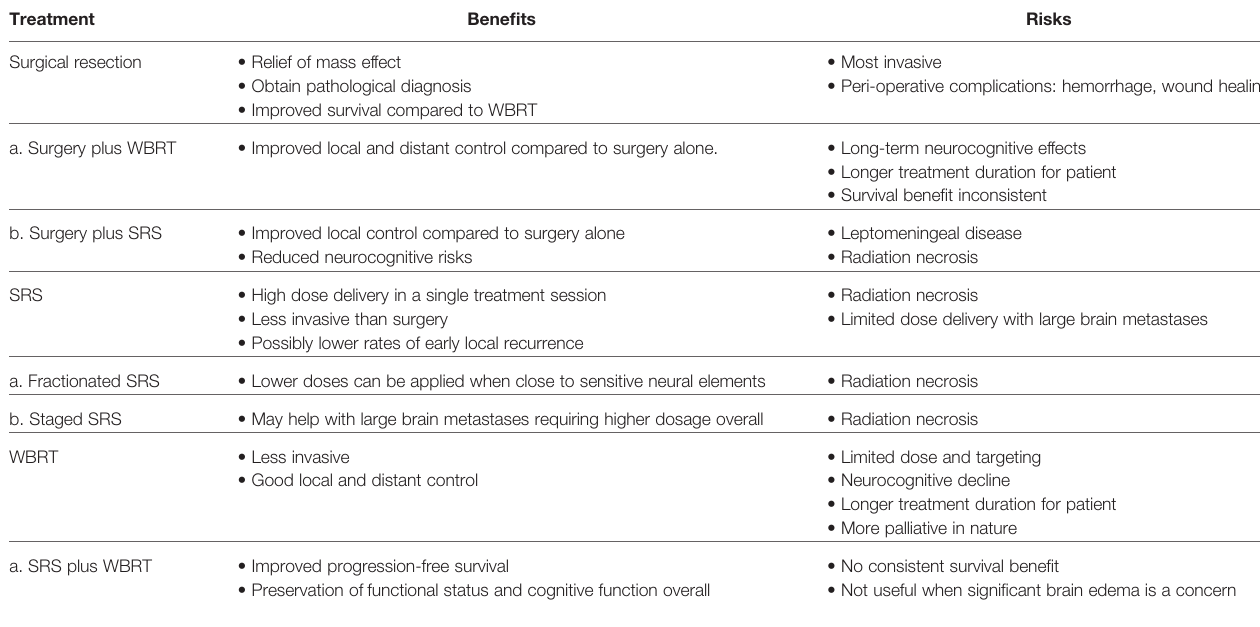
TABLE 1 | Overview of treatment strategies and their bene fi ts and risks.